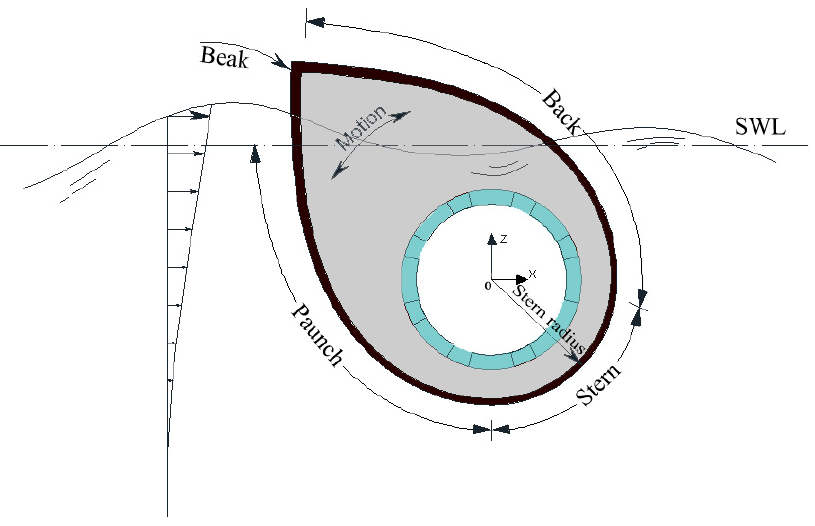
Figure 1. Schematic model of the isolated WEC rotor.